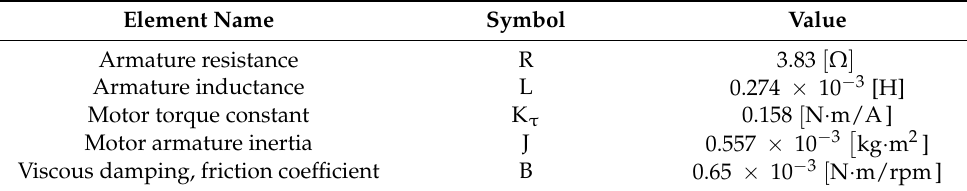
Figure 8. MATLAB Simulink modeling based on transfer functions and electrical circuits. Table 2. Parameters used in MATLAB Simulink model.